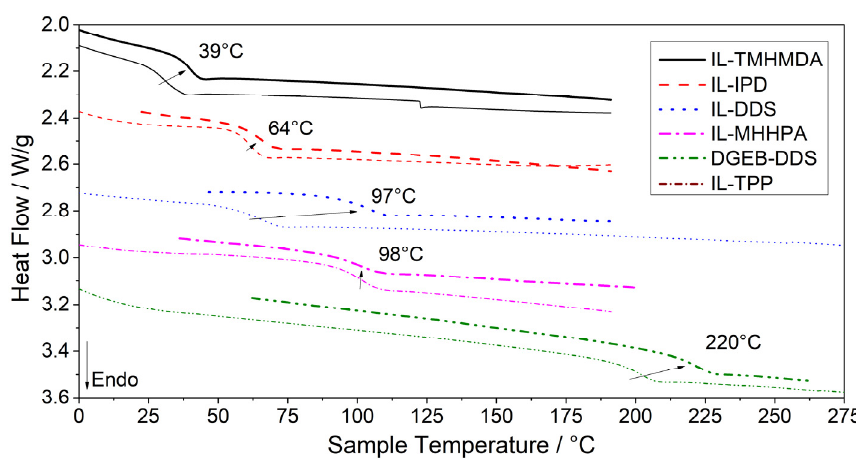
Figure 3. Shift of glass transition temperatures by prolonged post-curing (thick lines) compared to the second heating of uncured resins (thin lines) as determined in DSC. Curves shifted vertically for better visibility.